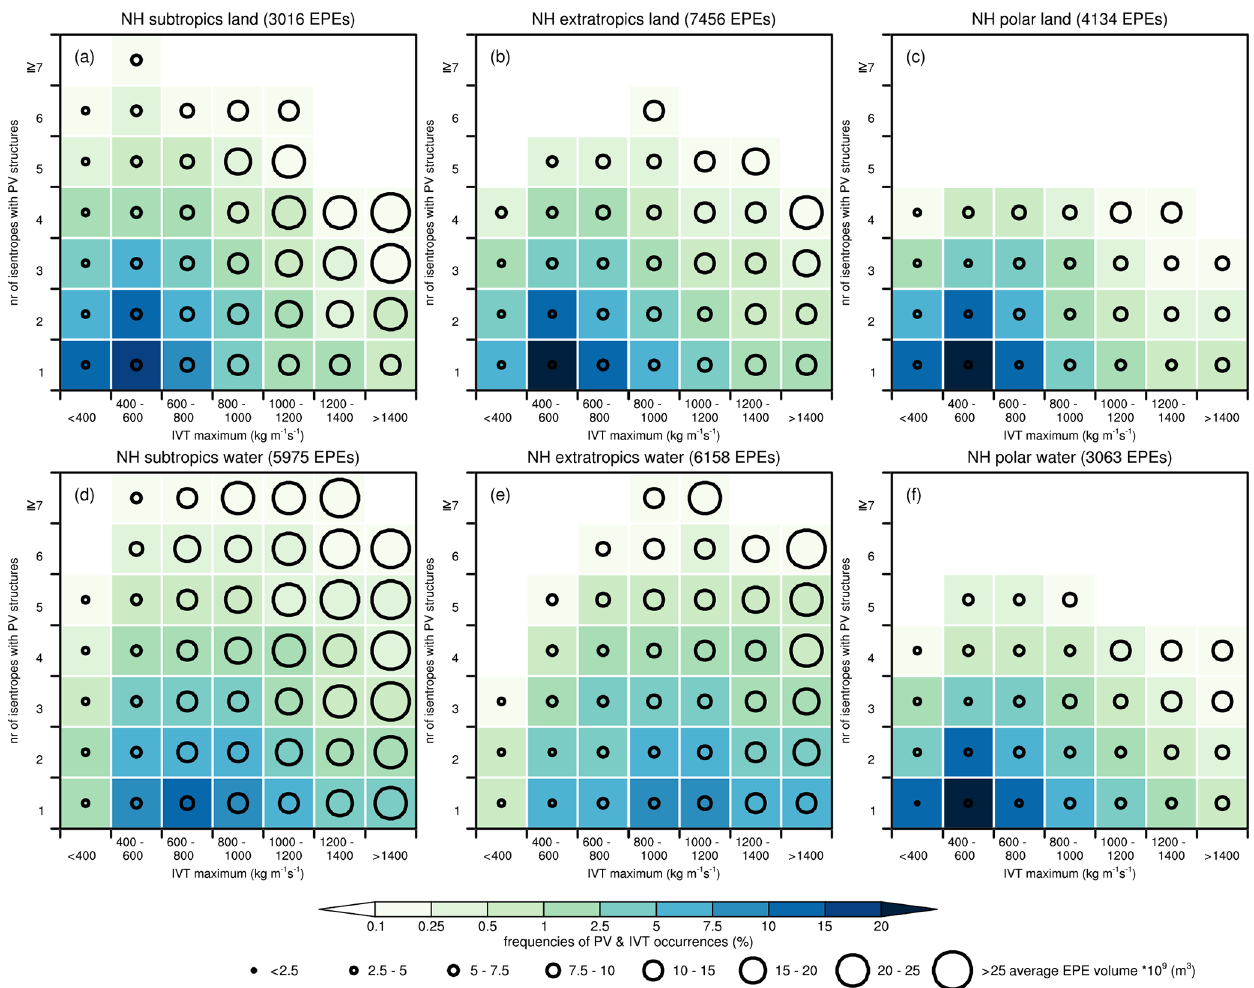
Figure 9. Average precipitation volumes of the EPEs in the circles, as denoted by the legend, for clusters defined by the number of isentropes with PV structures and the IVT maxima (kgm − 1 s − 1 ). As in Fig. 8, the plot is based on EPEs, linked to combined wave breaking and intense moisture transport, for identical regions. The colours of the squares reflect the frequencies (%) of 6-hourly time instances with PV and IVT structures that fall in the corresponding clusters relative to the total number of 6-hourly time instances during all EPEs that are linked to combined wave breaking and intense moisture transport. Circles for average precipitation volumes are not plotted where frequencies are below